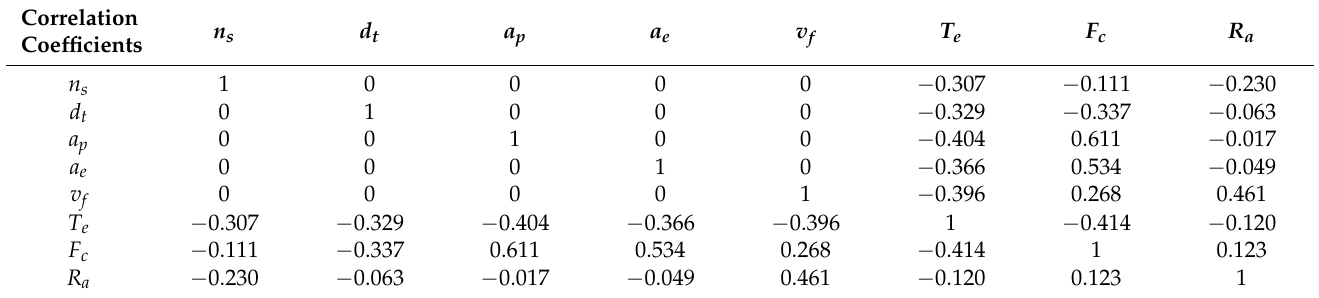
Table 7. Correlation coefficients between cutting parameters and design